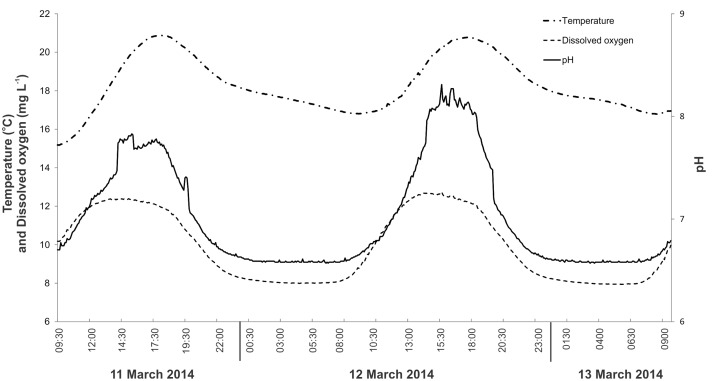
Dissolved oxygen (DO) concentrations (1-min intervals) measured within Phormidium mats in the ‘mesocosm chamber’ in the Mangatainoka River (site B, 11 to 13 March 2014).Solid arrows indicated where the DO optode was repositioned. Open arrows indicates where the pump which maintained the flow across the chamber failed.